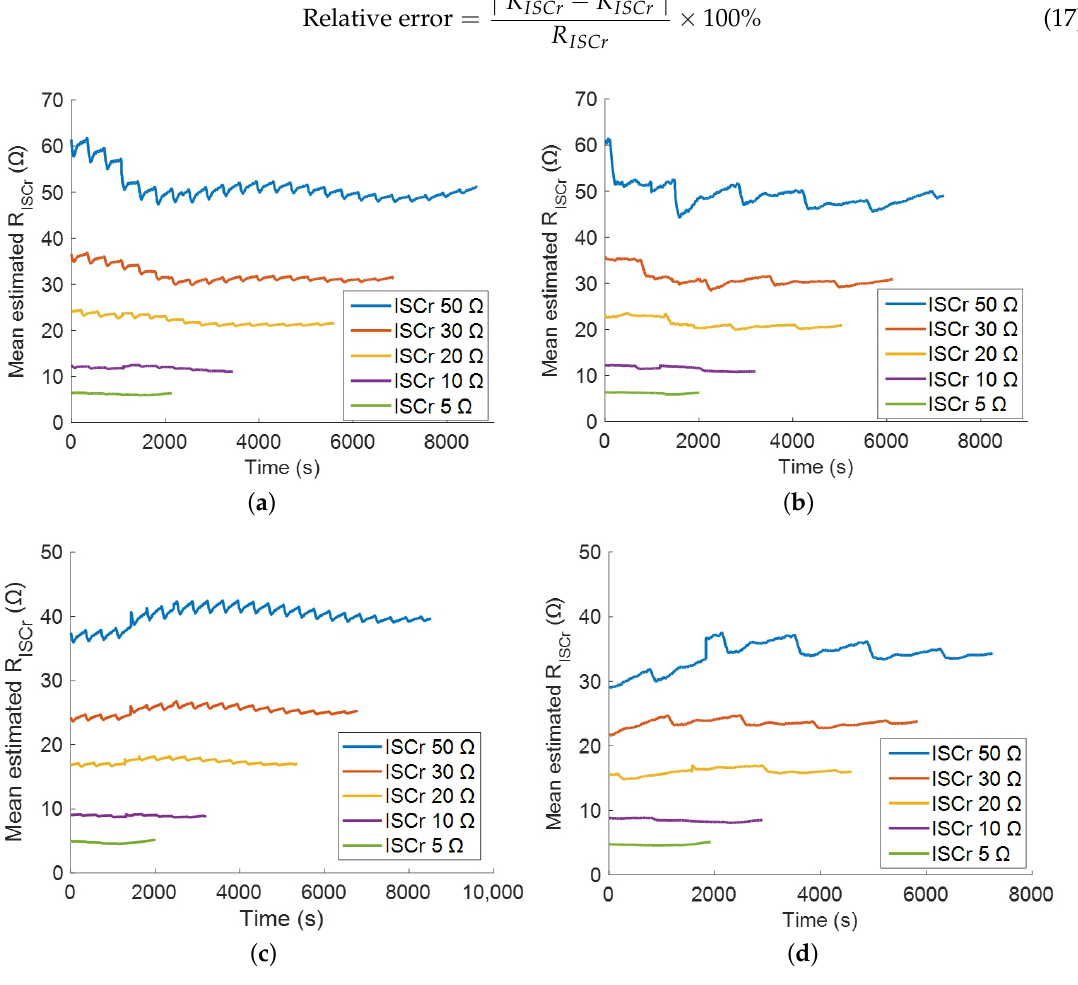
Figure 8. Estimated R ISCr s from the various ISCr fault cases in simulations: ( a ) DST current profile and ( b ) UDDS current profile and in experiments: ( c ) DST current profile and ( d ) UDDS current profile. Table 3. Final relative errors (%) of R ISCr in simulation depending on the ISCr